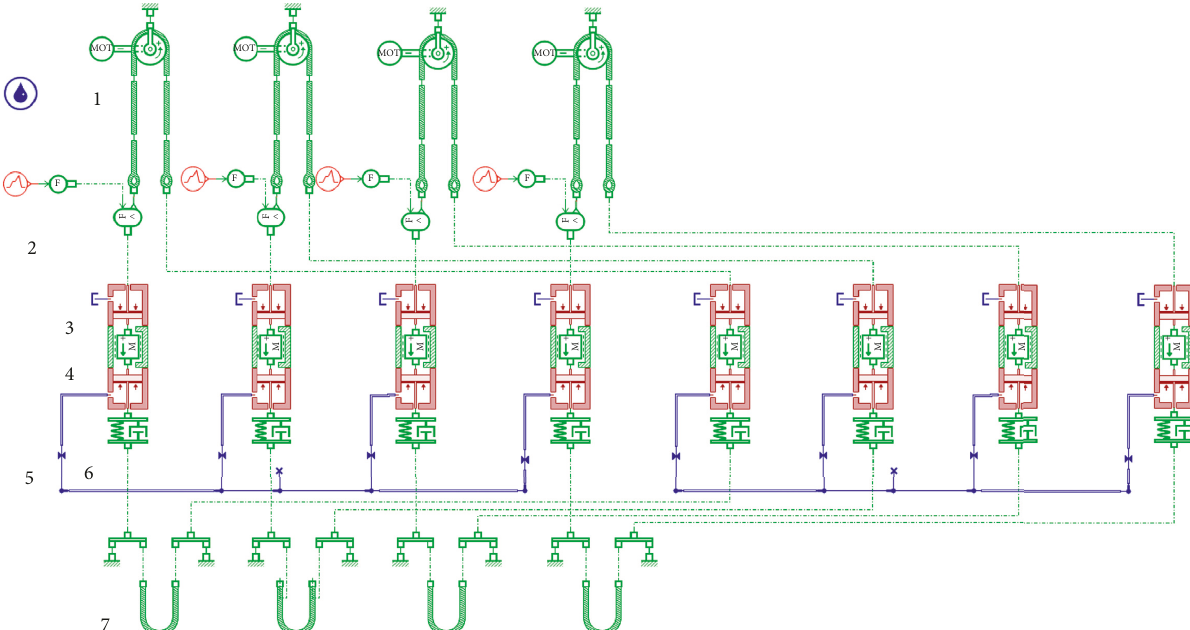
Figure 9: Simulation of the hydraulic connection device. 1, roller; 2, load signal source; 3, balancing cylinder; 4, friction mass block; 5, stop valve; 6, spring damping; 7, tail rope.